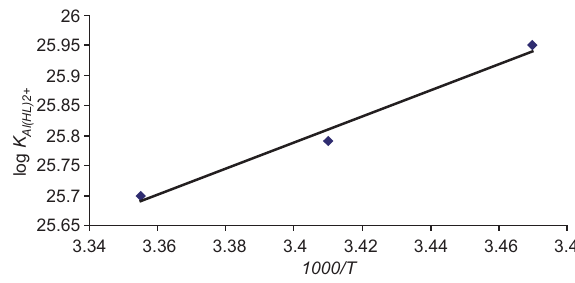
Figure 1 Plot of log K